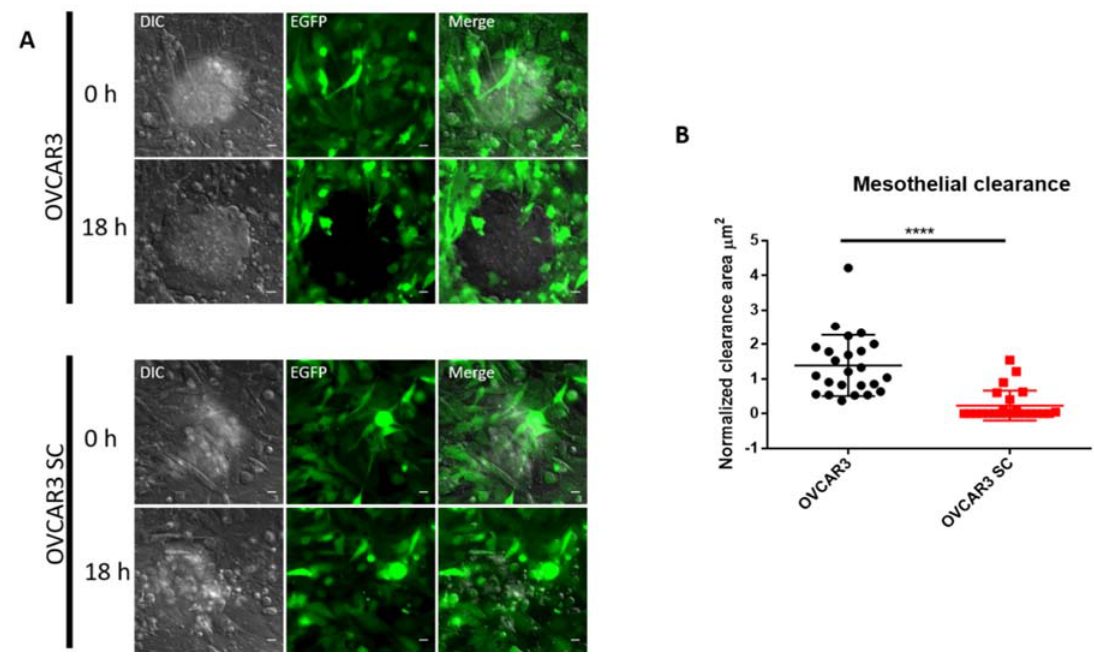
Figure 4. O ‐ glycosylation capacity affects mesothelial clearance of OVCAR3. ( A ) Representative images from mesothelial clearance assays of OVCAR3 (upper) and OVCAR3 SC (bottom), taken at 0 and 18 h of co ‐ culture; ( B ) Quantification of mesothelial clearance in parental OVCAR3 and OVCAR3